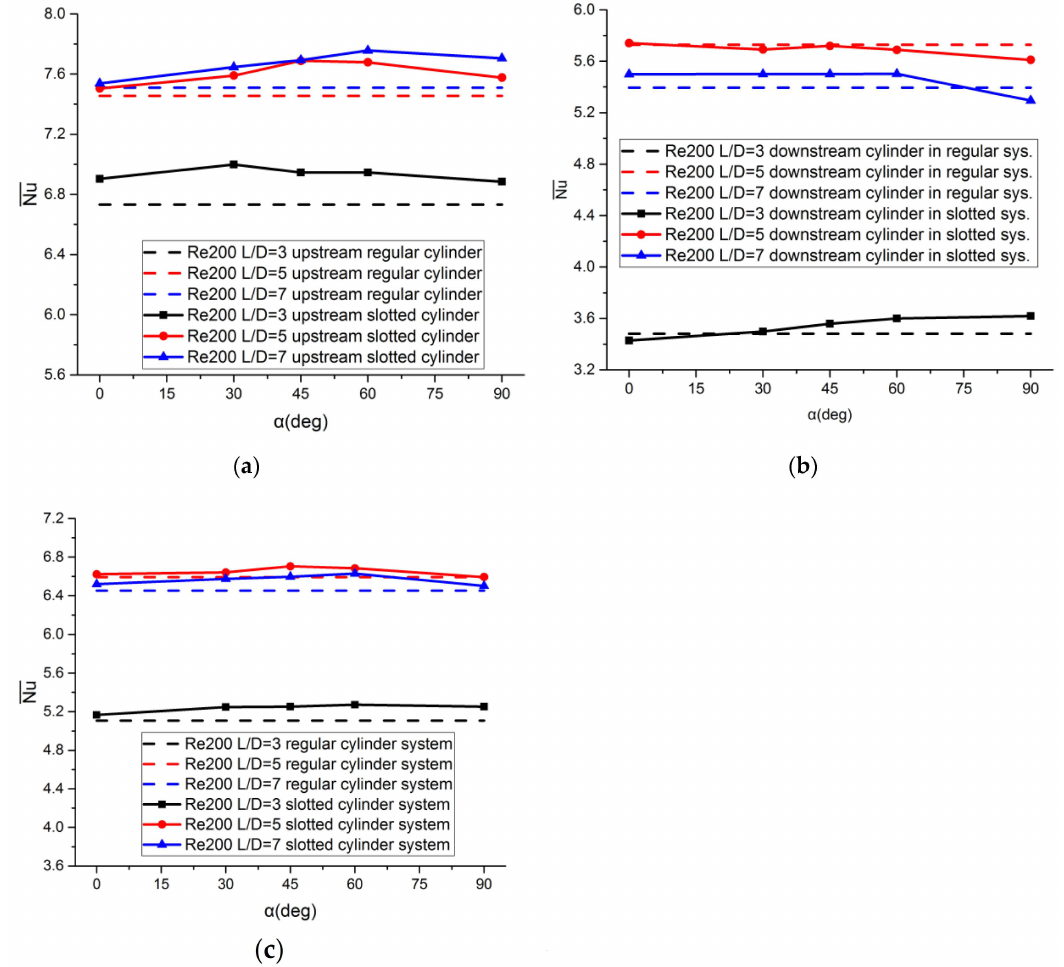
Energies 2021 , 14 , x FOR PEER REVIEW Figure 20. The time mean Nusselt number as a slit with different angles is employed on the upstream cylinder of the tandem array at Re = 200: ( a ) upstream cylinder; ( b ) downstream cylinder; ( c ) array system.